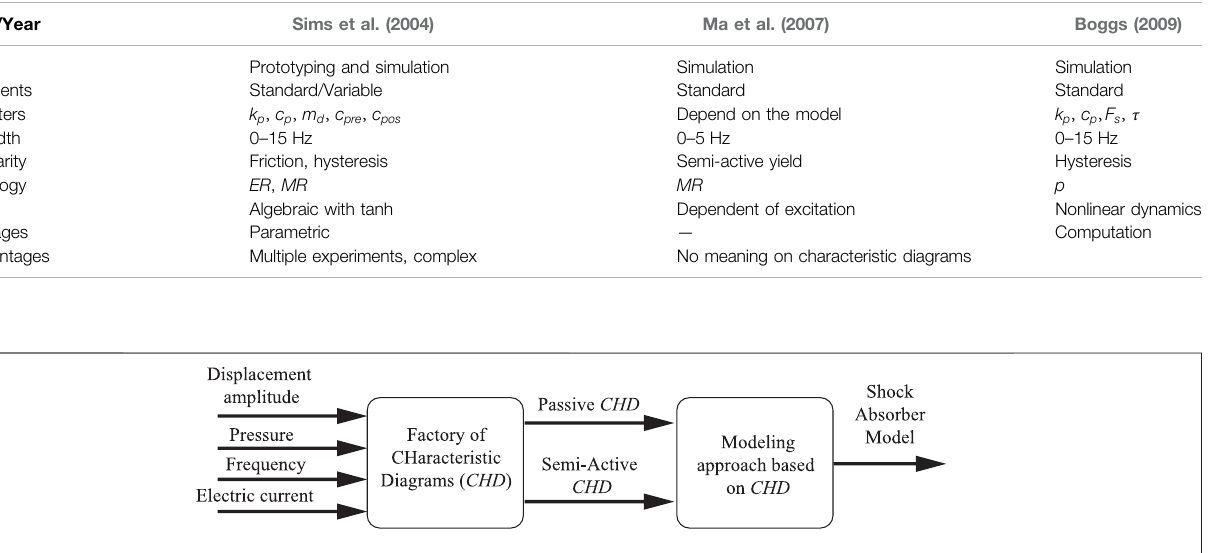
FIGURE 1 | General block diagram of the CHD -based approach for shock absorbers modeling.